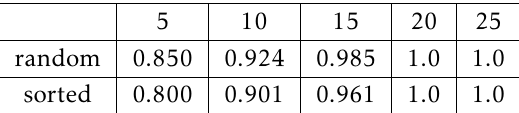
Figure 10. Random initial values. Figure 11. Sorted initial values. Table 2. Probability of Detection